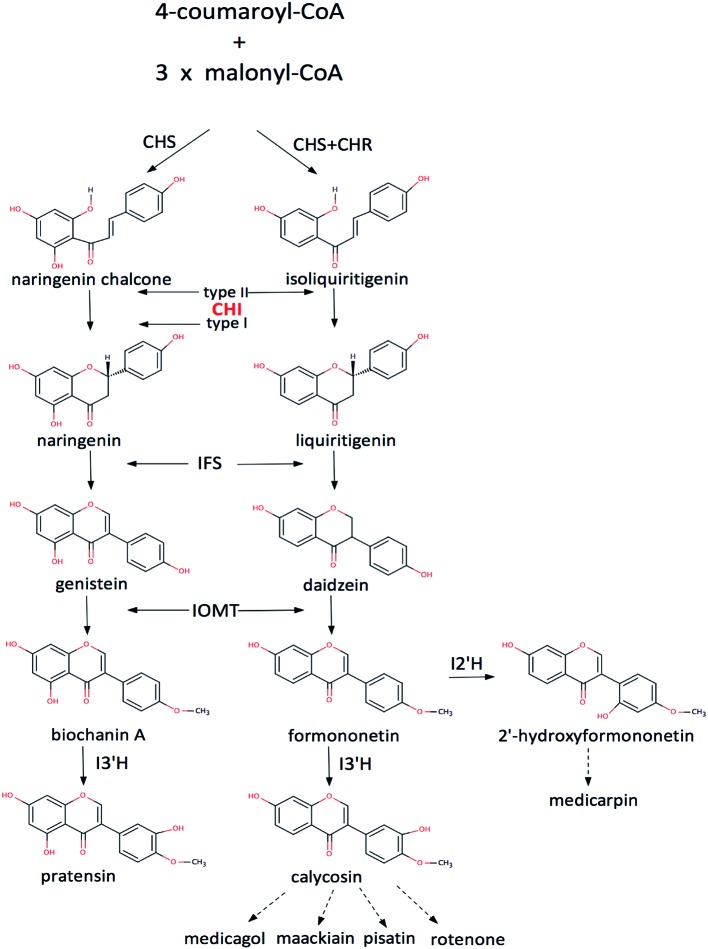
The flavonoid pathway. CHS, chalcone synthase; CHR, chalcone reductase; IFS, isoflavone synthase; IOMT, 2′-hydroxyisoflavanone 4′-O-methyltransferase; I2′H, isoflavone 2′-hydroxylase; I3′H, isoflavone 3′-hydroxylase (Liu and Dixon, 2001; Liu et al., 2002, 2003; Shimada et al., 2003).